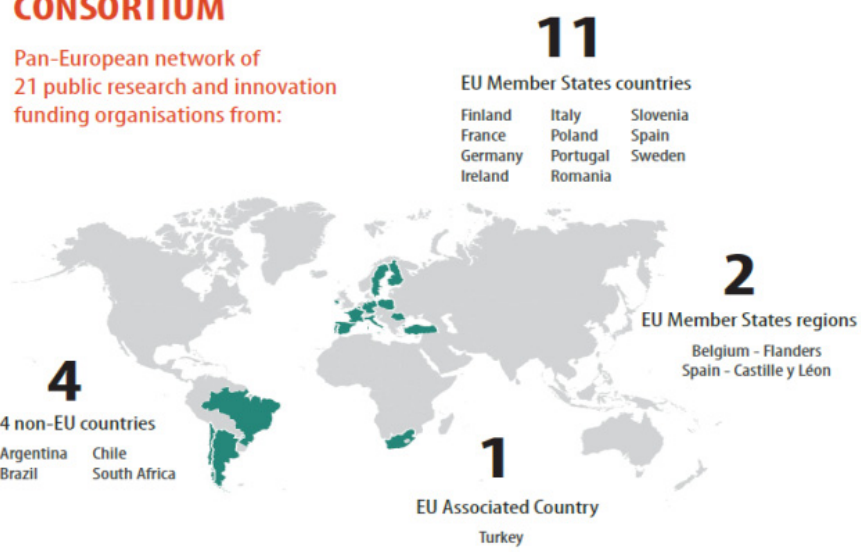
Figure 2. ERA-MIN 2 consortium of funding organisations—countries/regions (FCT—Portugal;